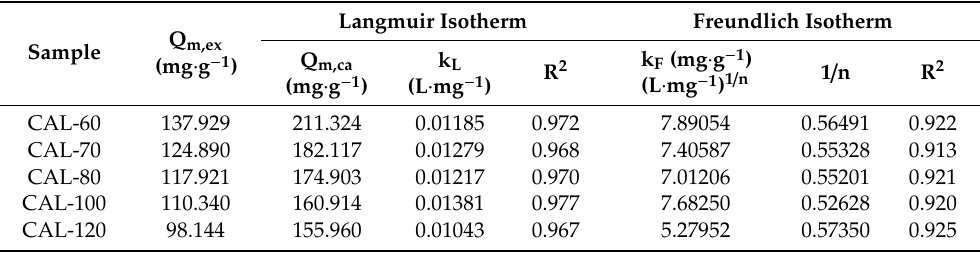
Table 2. Experimental data of Cl − uptake on CAL samples at equilibrium and fitting parameters achieved from Langmuir isotherm and Freundlich isotherm.